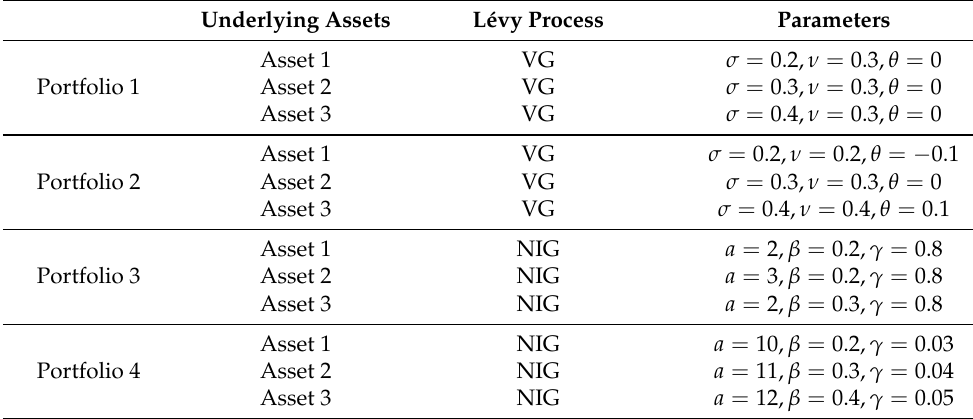
Table 2. The parameters setting of Lévy process for each underlying